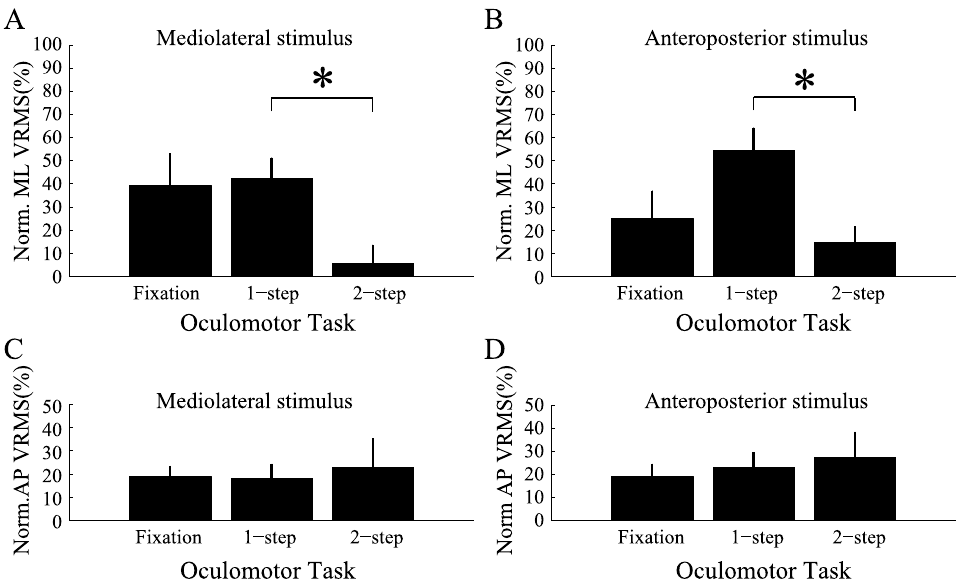
Fig 6. Mean normalized 1-D vRMS as a function of oculomotor task. Checkerboard stimulus moving in the (B,D) anteroposterior and (A,C) mediolateraldirections. Mediolateral (A,C) and anteroposterior (B,D) postural measuresare presentedin separatepanels. Data from all subjects and trials was pooled.Error bars = standard error of the mean. * denotesa significantdifference (p < 0.05). ML = mediolateral, AP = anteroposterior.